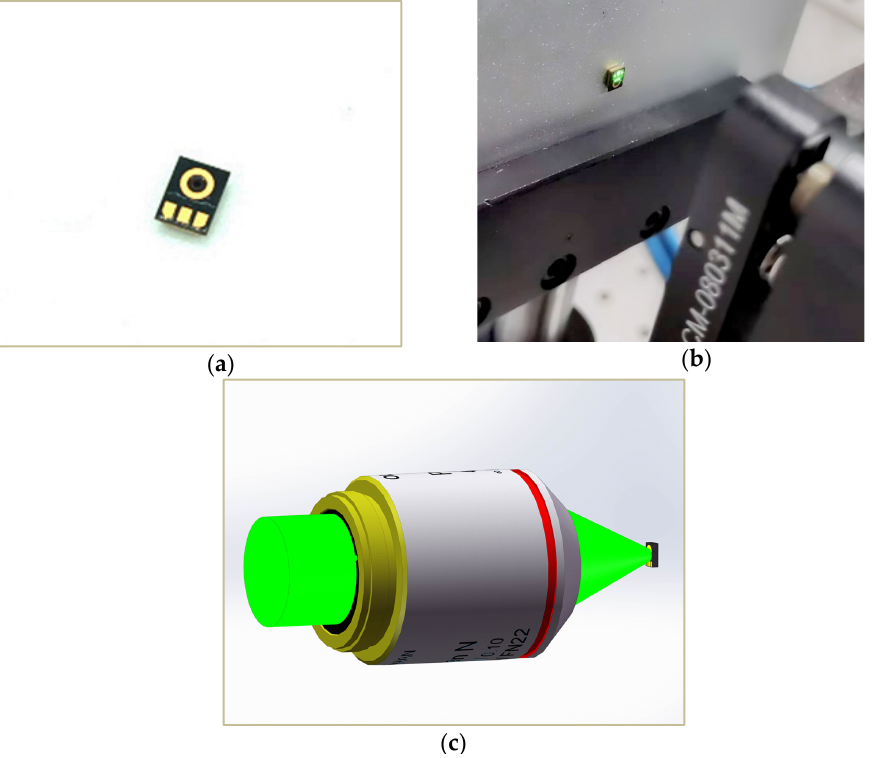
Figure 6. ( a ) The measured object used for speckle interference; ( b ) The circular spot formed by the beam passing through the microscope objective; ( c ) The schematic diagram of magnified microscopic speckle.